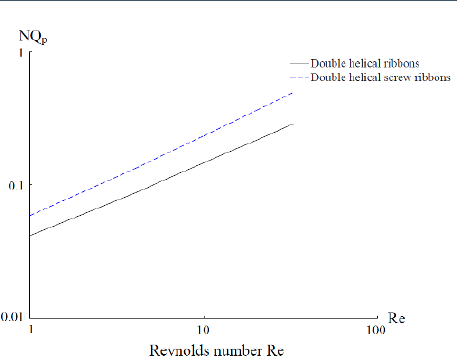
p =f(Re). Figure 15. Energy efficiency variation E